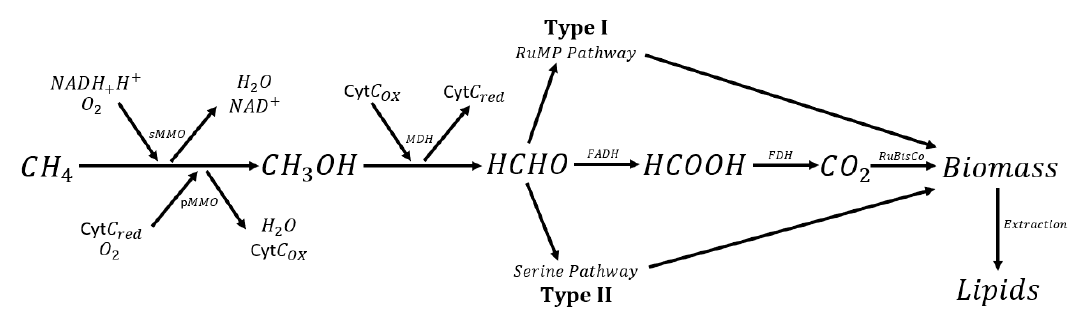
Figure 2. Process Used by Methanotrophic Bacteria for the Conversion of Methane into Biomass (Hanson and Hanson, 1996).